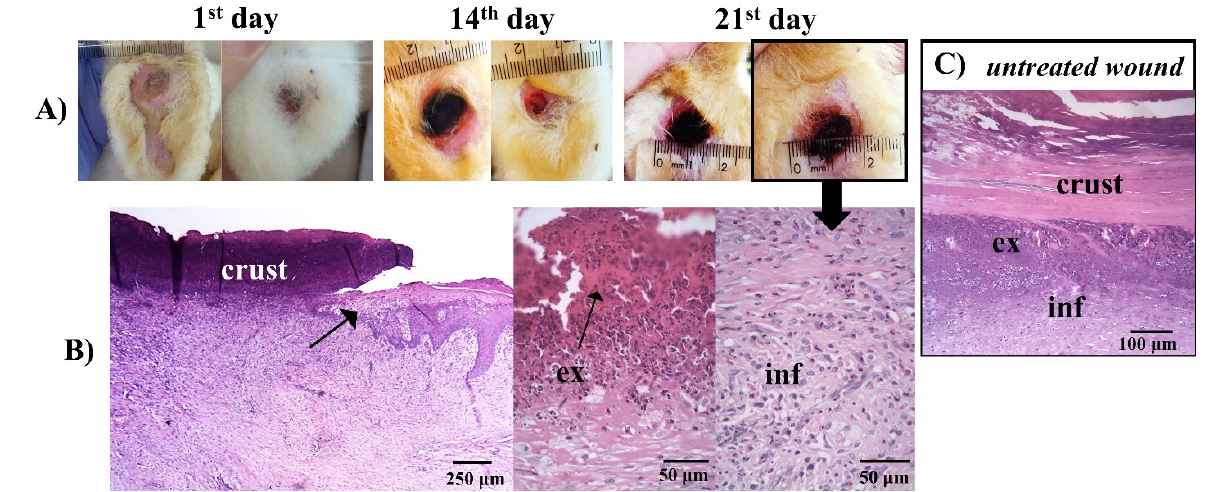
Figure 11. ( A ) Macroscopical aspects of the plantar face of feet in rabbit breeders during control treatment. ( B ) Histological appearance on the lesion areas in the last day of treatment with iodine. The arrow in the photo indicates the border of the wound. The wound area surface was characterized by debris and exudate (ex), and a concentration of polymorphonuclear and inflammatory cells (inf) in the dermis. ( C ) Photomicrographs of histological aspects of untreated wounds. ( B , C ) Paraffin section, HE.